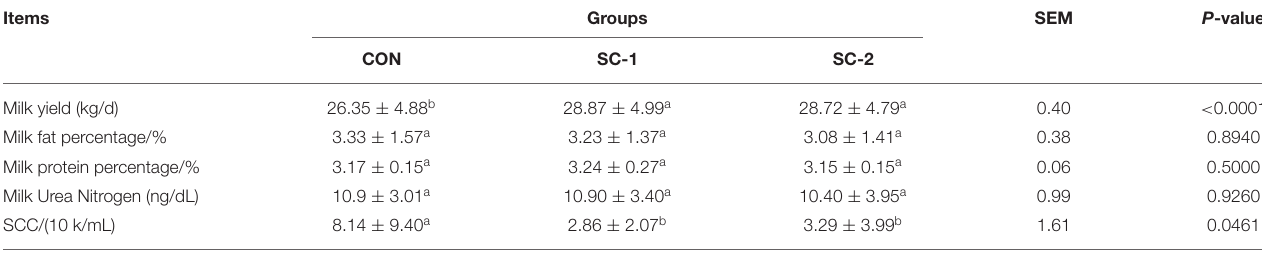
TABLE 4 | Effect of different Saccharomyces cerevisiae cultures on the productive performance of dairy cows. Items Groups